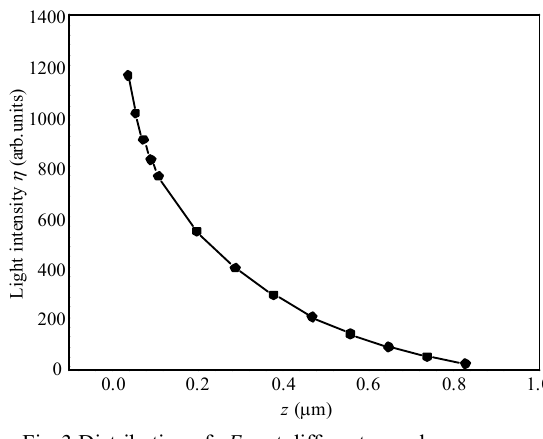
E at different x – y planes. Fig. 3 Distribution of z